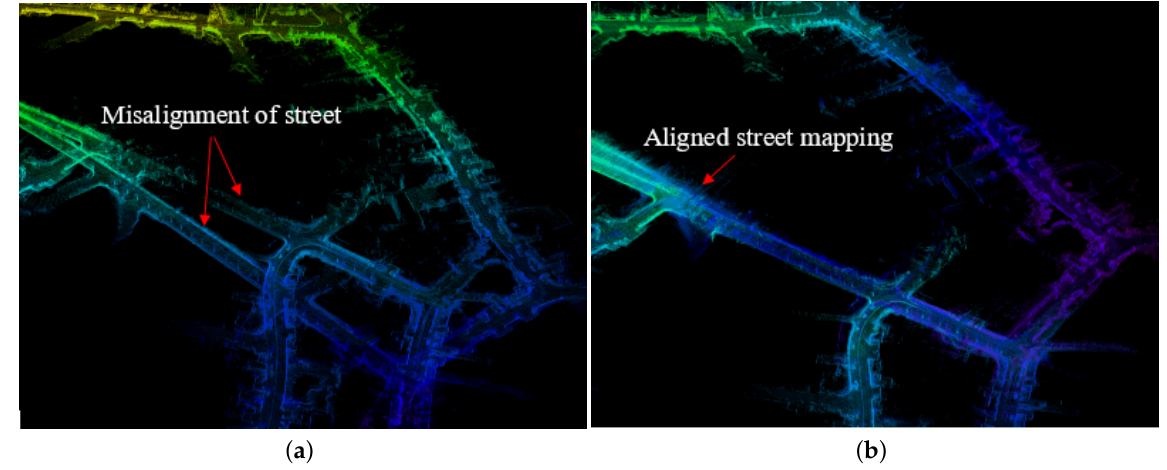
Figure 13. Mapping Results of LOAM with and without ITM on KITTI Dataset 02. ( a ) LOAM without ITM. ( b ) LOAM With